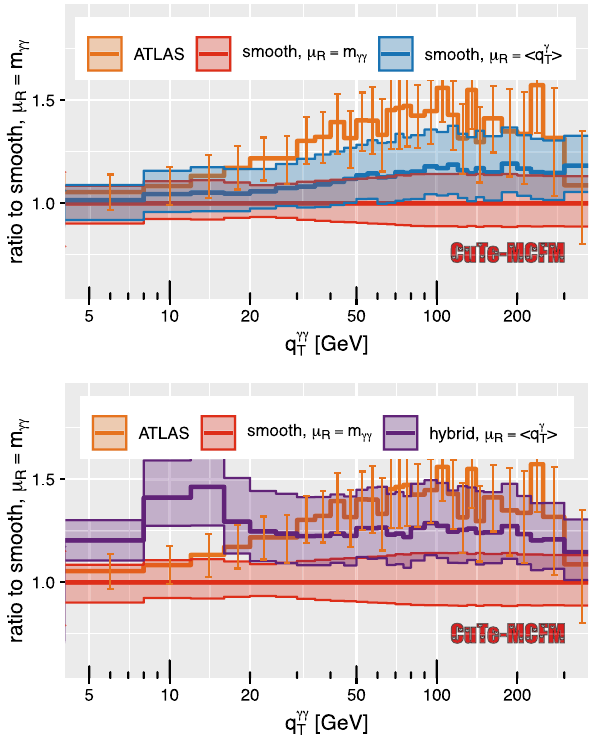
Fig. 6 Fully matched φ ∗ spectra at N 3 LL (cid:2) + NNLO in comparison with the ATLAS measurement. Top plot: Ratio to N 3 LL (cid:2) with smooth- γ (cid:9) . cone isolation and μ R = m γγ in comparison with data and μ R = (cid:8) q T Bottom plot: Similar, but in comparison with prediction using hybrid- γ cone isolation and μ R = (cid:8) q T